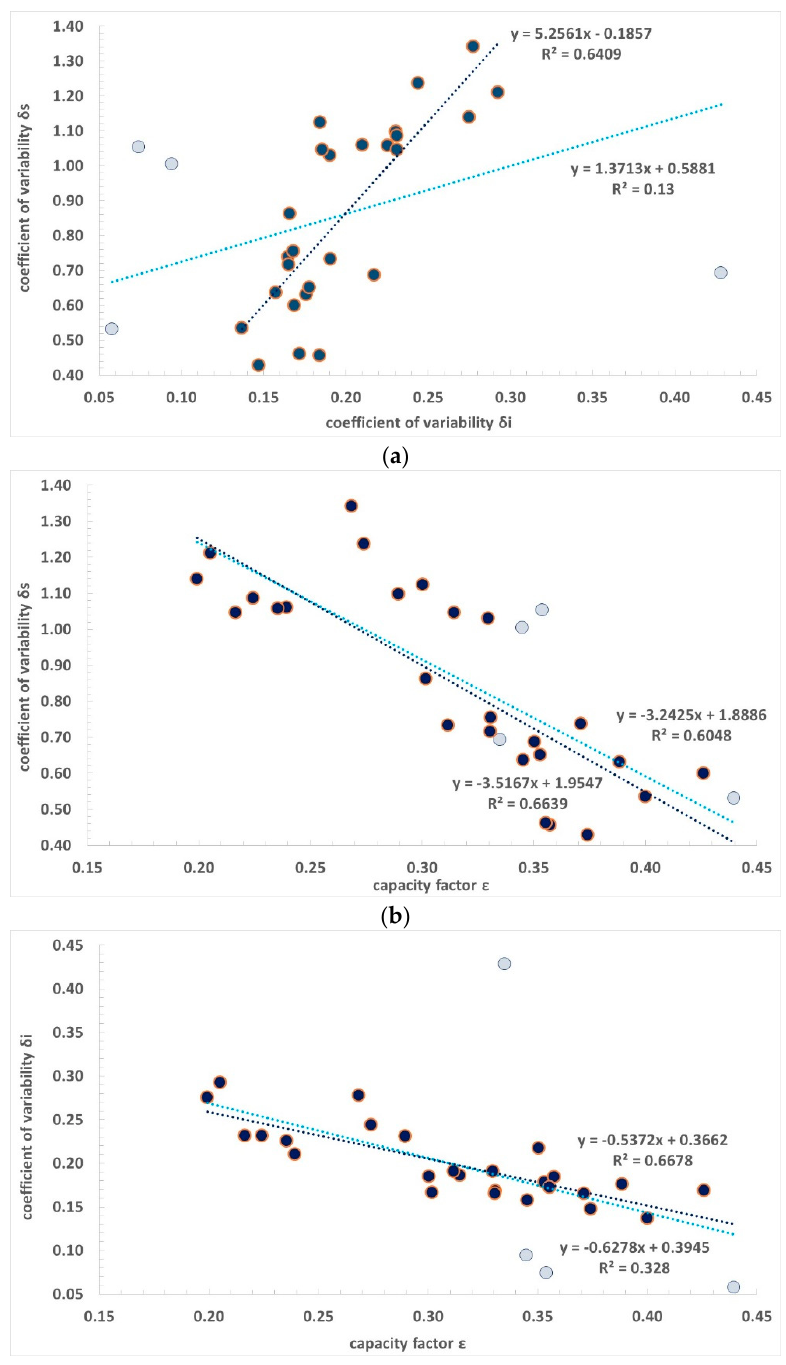
Figure 10. Summary results of δ s and δ i of the different units of WEF of Tables 2–7, and of the WEF of Table 8, having a minimum of 3 years of data to compute δ i (maximum was 5 years of data). δ s was computed for the year 2016 where most parts of the data were available, and for the year 2017 when the full year 2016 was not available. A marker with a darker color is used for the population with outliers removed. ( a ) δ s vs. δ i ; ( b ) δ s vs. ε ; and ( c ) δ i vs. ε . δ s was reducing linearly with ε , with a proportionality factor much larger than unity (values from − 3.24 to − 3.52). δ i was also reducing linearly with ε , but with a proportionality factor much smaller than unity (values from − 0.54 to − 0.63).